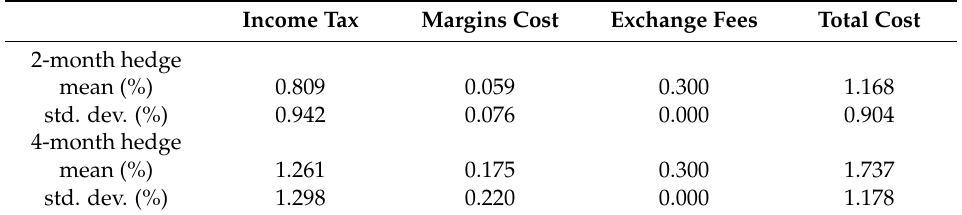
Table 3. Mean and standard deviation of transaction costs in futures trading based on simulated price trajectories with annual price volatility of 30% (a) .